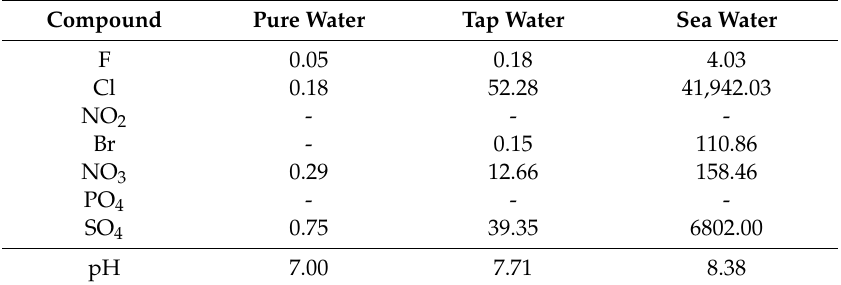
Table 2. Composition (ppm) and pH of pure water, tap water, and sea